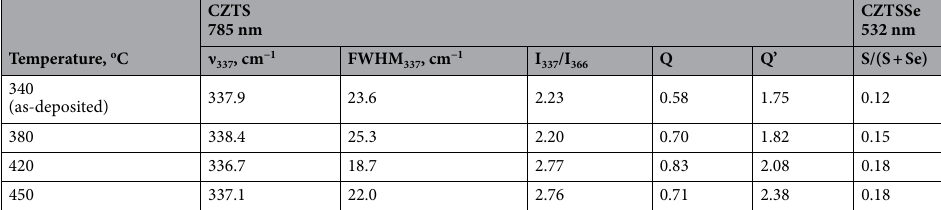
Table 3. The position of the dominant A symmetry band, its full-width at half maximum (FWHM) values, I 337 / I 365 , Q, and Q’ ratios for 785 nm-excited CZTS and quantity factor expressed as S/(S + Se) for 532 nm-excited CZTSSe Raman